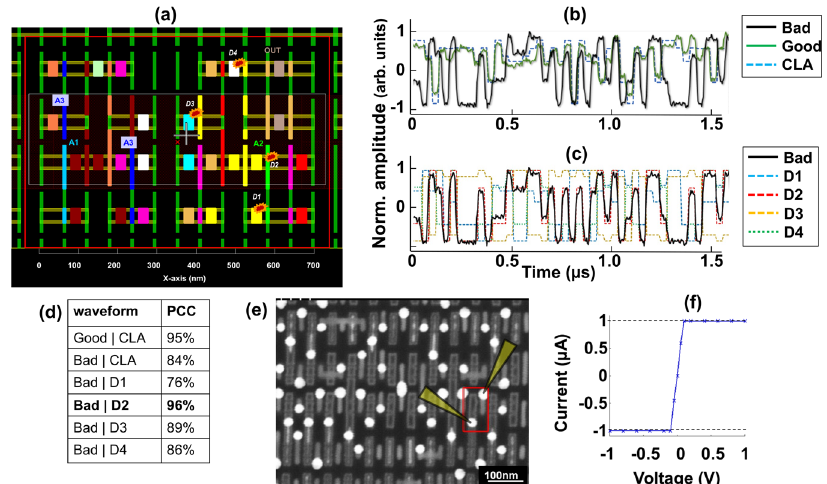
Fig. 4 | Accurate defect location prediction using waveform simulation. a Physical layout of the failing cell showing internal connections. A1 – A3 are inputs to the cell. Also highlighted are few potential defects (short)(D1 – D4) that could explainthefailure. b Rawwaveformscollectedfromthefailingcell(solidblack)and an identical good cell (solid green), with the reference CLA waveform (dashed blue). The bad waveform has many mismatches, particularly when input A2=1. c Waveforms overlaid with CLA simulations of defective cells with defects D1 – D4.